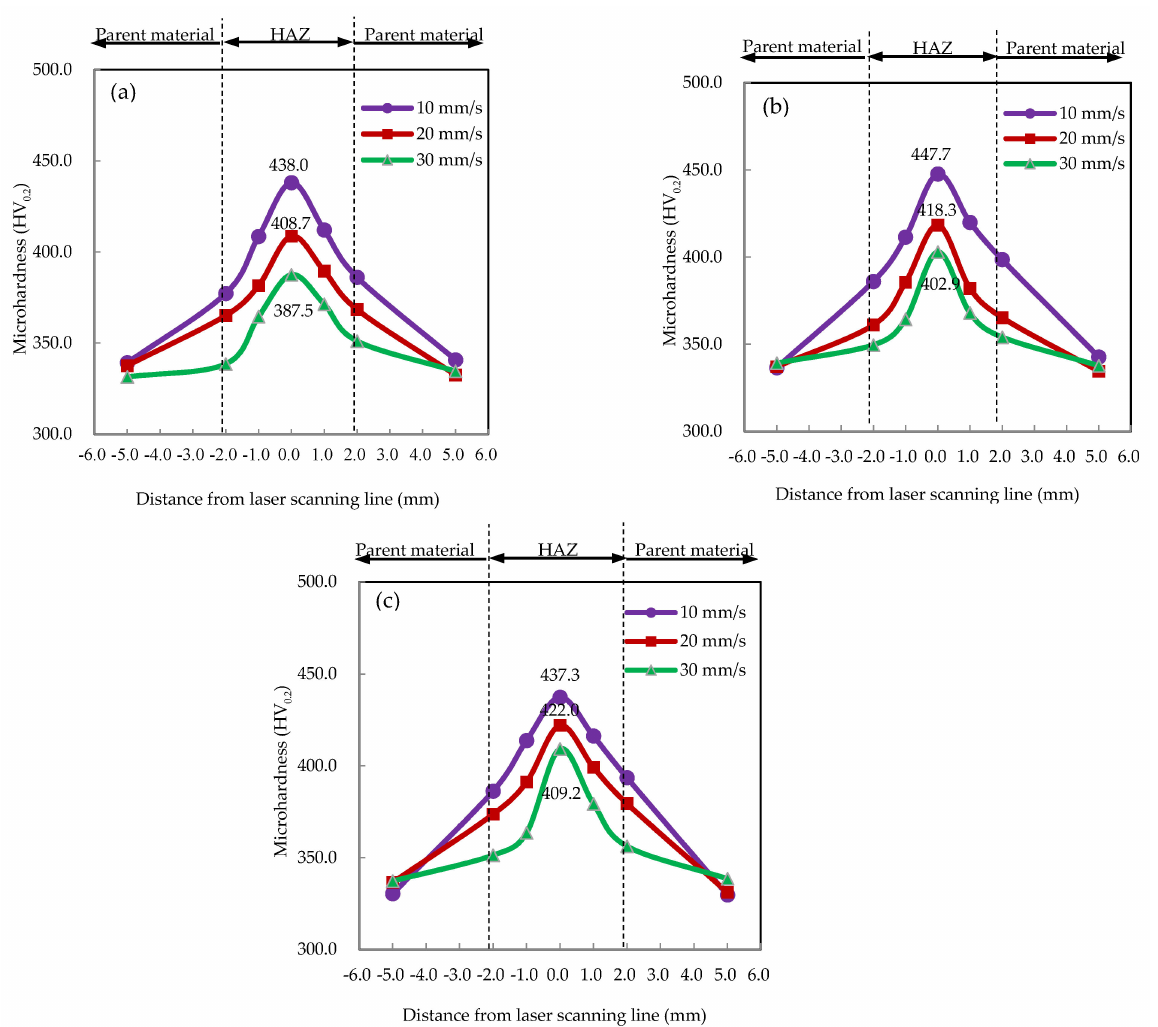
Figure 8. Microhardness distributions of the laser-formed plates under constant laser powers of